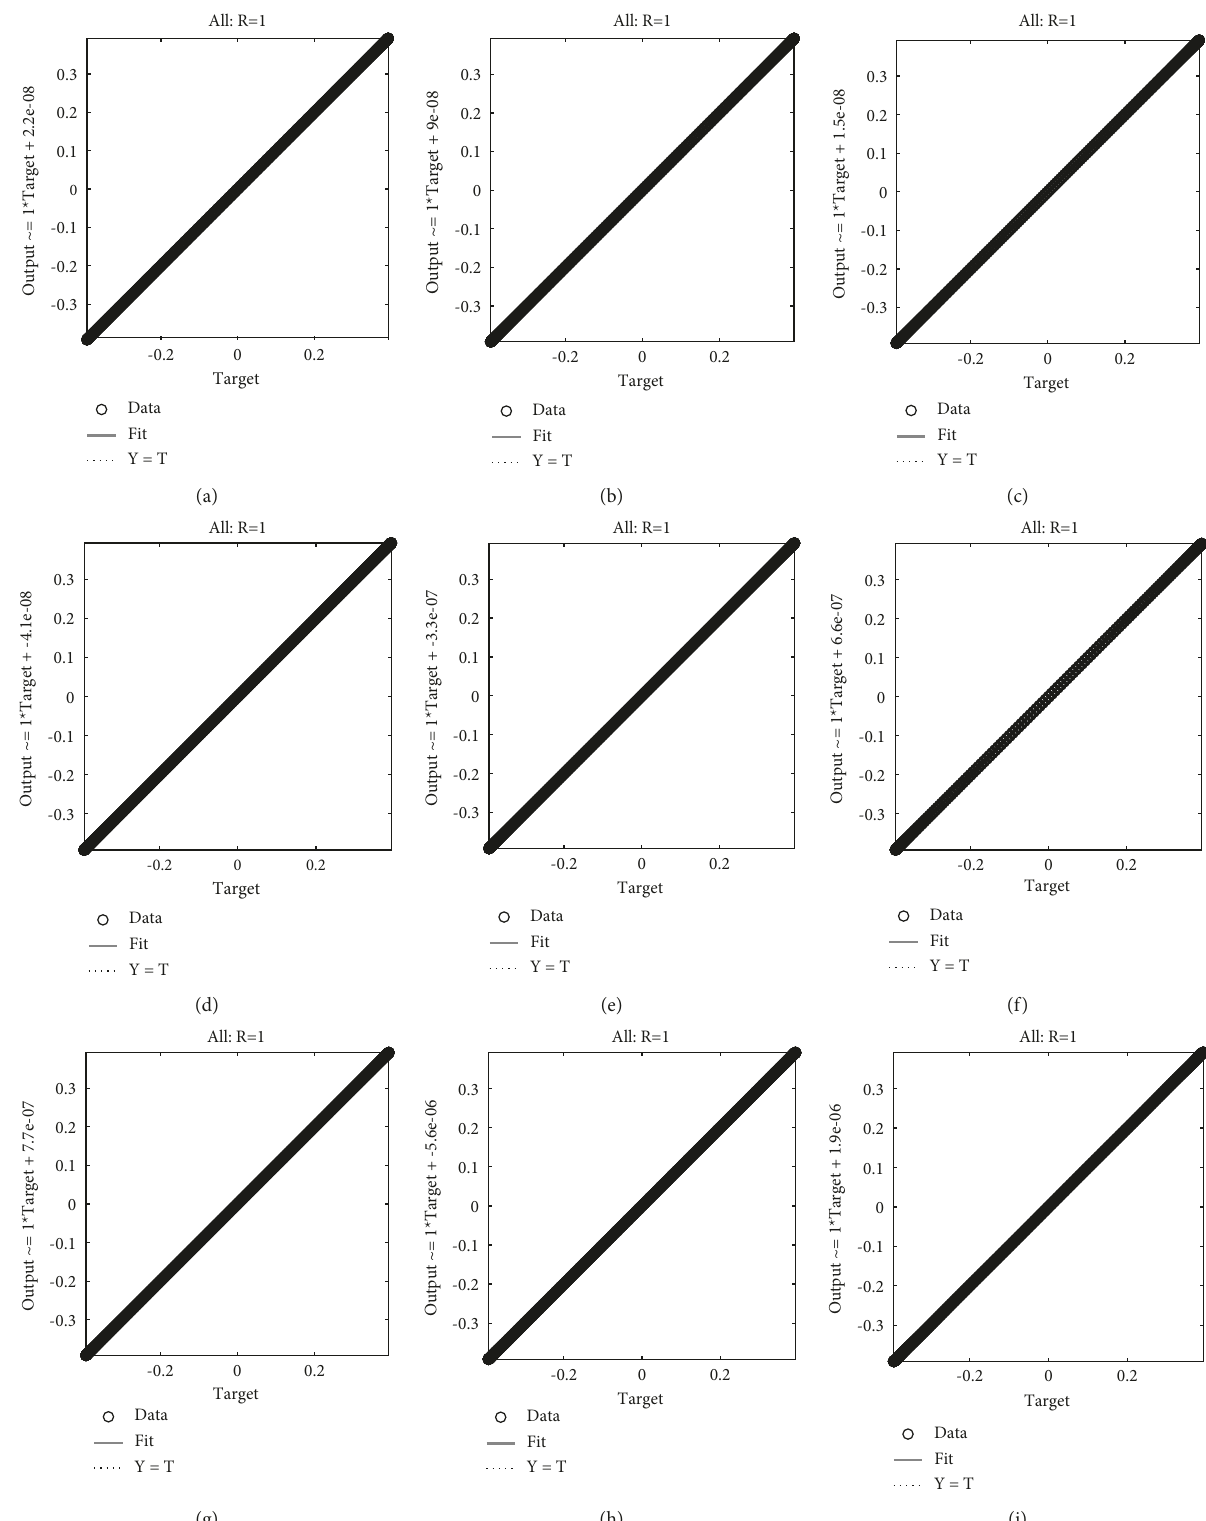
Figure 9: Regression analysis for each case of scenarios 1, 2, and 3 of a homogenous circular